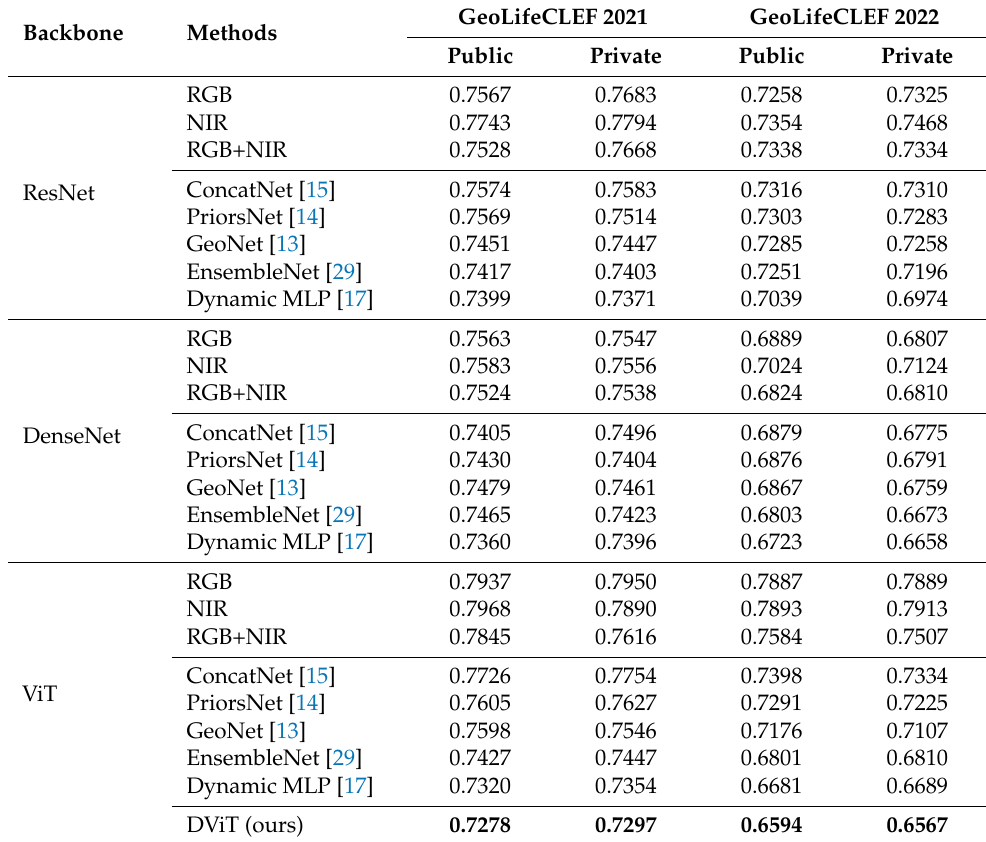
Table 6. The top-30 error rate with image-only and multimodal fusion models using the GeoLifeCLEF 2021 and 2022 public dataset (left) and private dataset